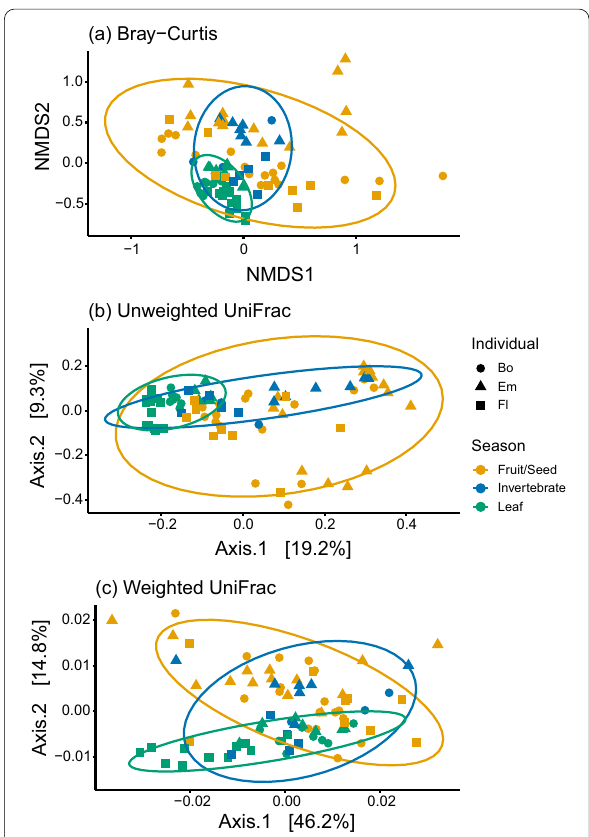
Fig. 4 Beta diversity indices of Japanese macaque gut microbiome among different seasons and individuals. ( a ) NMDS (nonmetric multidimensional scaling) by Bray–Curtis dissimilarity; ( b ) PCoA (principal coordinate analysis) by Unweighted UniFrac distance, ( c